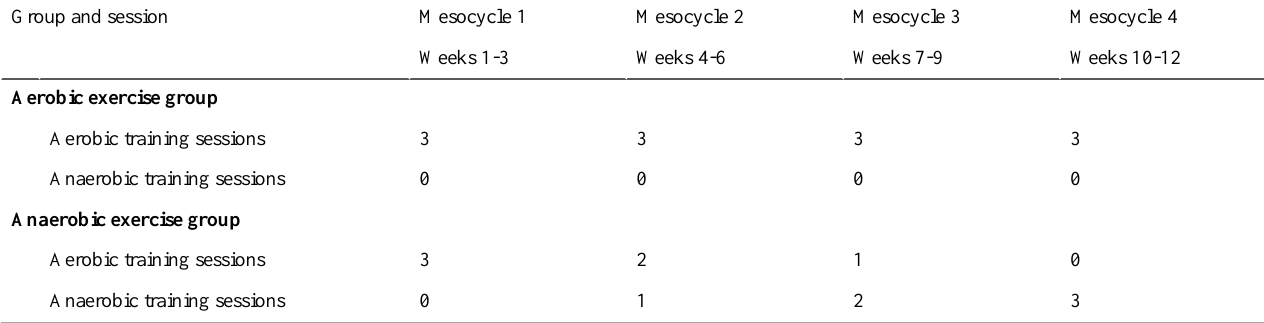
Table 4. Number of aerobic and anaerobic training sessions for each